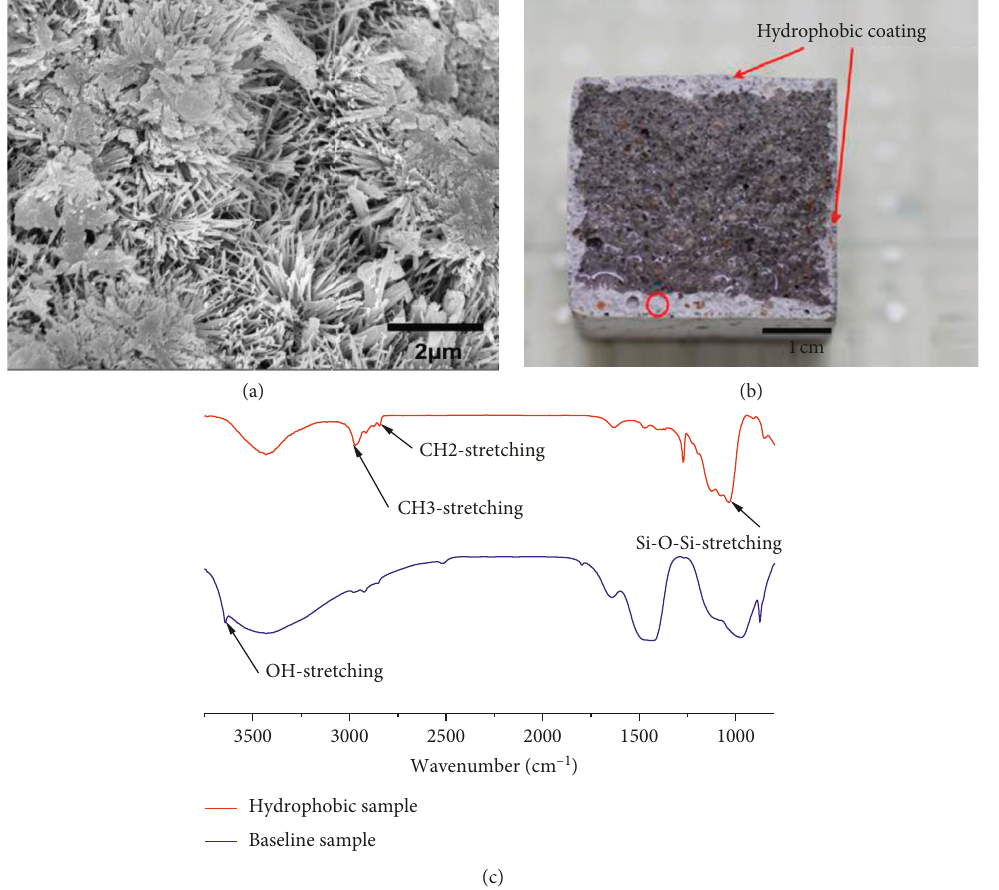
Figure 12: Microscopic analysis and chemical characterization of the hydrophobic coating: (a) hydrophobic sample, (b) SEM photograph of the hydrophobic coating, and (c) FT-IR spectra of the